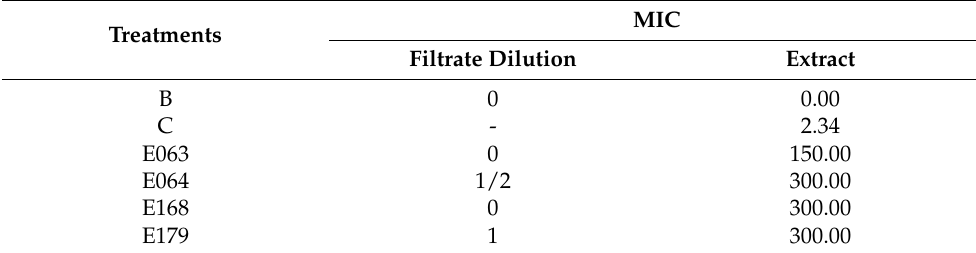
Table 1. Minimum inhibitory concentration (MIC) values of the filtrates (expressed in ratio for one unit) and extracts (expressed in μ g mL −1 ) of each endophyte against Phytophthora cinnamomi in com- parison with a positive control using cycloheximide (C) and a negative one using yeast extract me- dium (B).